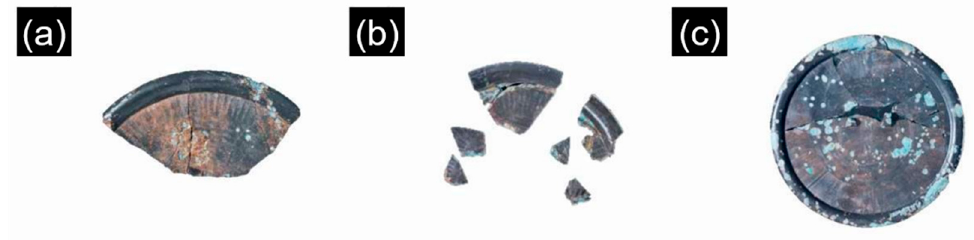
Figure 1. Bronze mirrors from the Sinpung Site in Wanju labeled ( a ) Ga-2, ( b ) Ga-31, and ( c ) Ga-35.